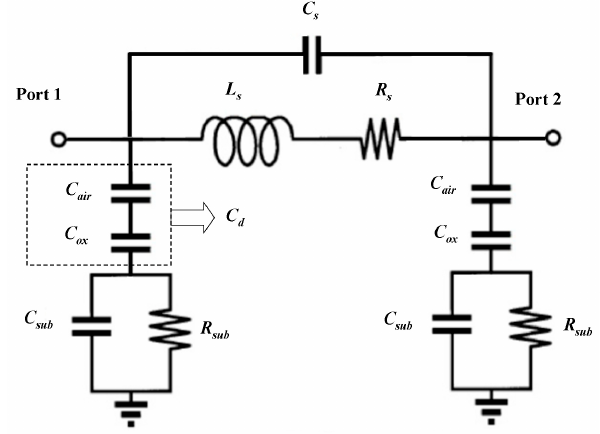
Figure 17. The π lumped-element equivalent model of MEMS suspended inductor.